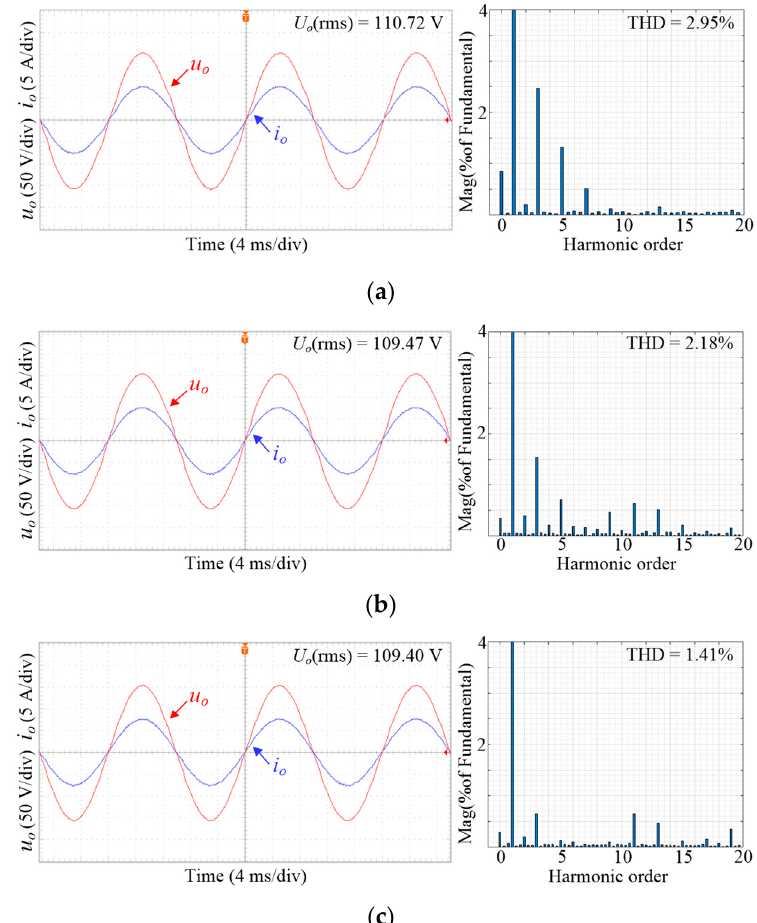
Figure 14. Steady-state waveforms of different control strategies under rated resistive load (20 Ω ) with ( a ) LADRC; ( b ) SRFPI-LADRC; and ( c ) HC-SRFPI-LADRC.